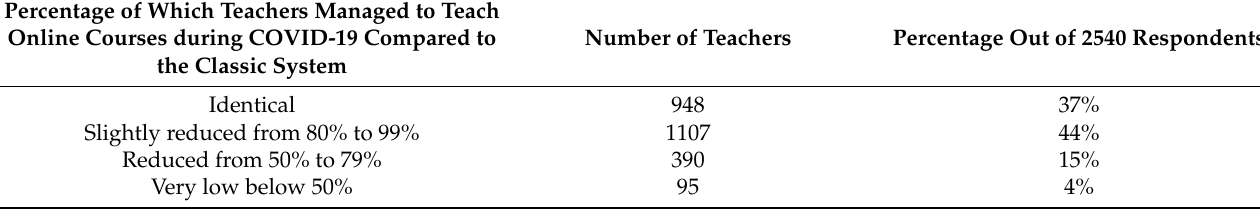
Table 6. The percentage of which teachers managed to teach online courses during COVID-19 compared to the classic version, prior to COVID-19 (question 2).